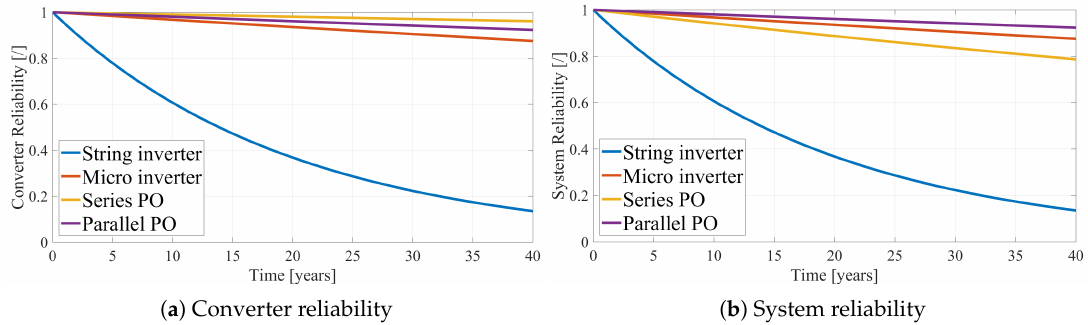
Figure 3. The predicted reliability of the different electrical architectures based on manufacturer reliability data. Note that repair is not modeled since the integrated converter is not servicable when installed in the module frame. The string inverter shows the lowest reliability but is installed on a servicable location which allows